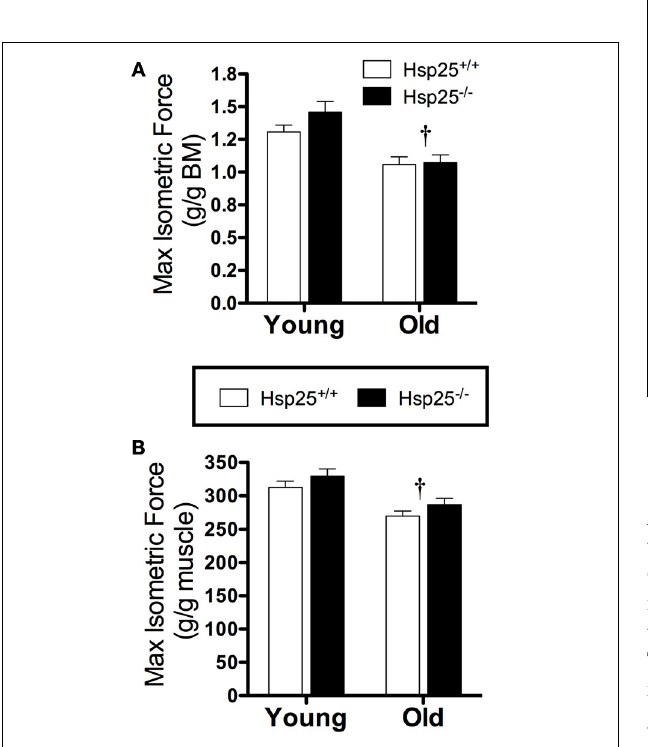
FIGURE 2 | Average maximal isometric plantarflexor force normalized to body mass (BM) (A) or gastrocnemius muscle mass (B) in young and old Hsp 25 + / + and Hsp 25 − / − mice. † Significant main effect of age ( P < 0 . 0001 and P = 0.0002, respectively). Data are presented as means ± SE, n = 8 for all groups.